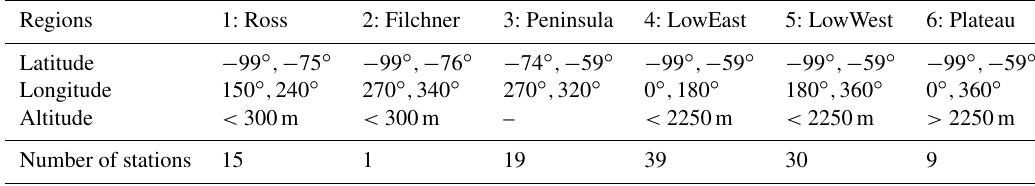
Table B1. Selection criteria applied to define the studied regions.